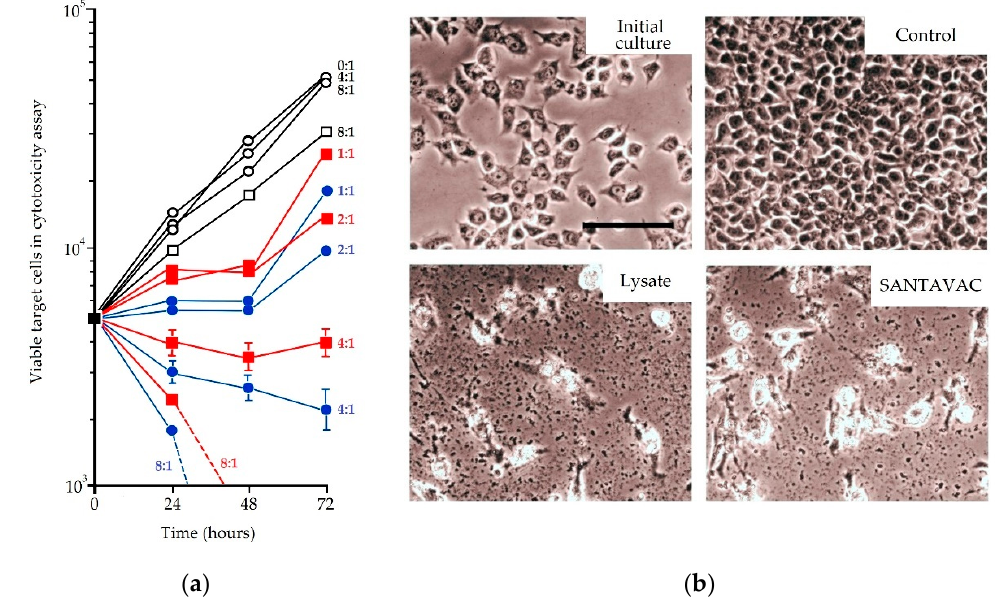
Figure 1. Antigenic equivalence of Set of All Natural Target Antigens for Vaccination Against Cancer (SANTAVAC) to whole cell lysate. ( a ) Cytotoxicity of effector CTLs against MCF-7 cells. Target MCF-7 cells were seeded in tissue culture plates, and then effector CTLs were added at CTL:MCF-7 ratios ranging from 1:1 to 8:1. A ratio of 0:1 indicates growth of MCF-7 cells to which effector CTLs were not added. ( ● ) MCF-7 cells incubated with CTL that had been stimulated with SANTAVAC-loaded DCs. ( ■ ) MCF-7 cells incubated with CTL that had been stimulated with lysate-loaded DCs. ( ) MCF-7 cells incubated with CTL that had been stimulated with unloaded DCs. ( ○ ) MCF-7 cells grown either alone, or with unstimulated PBMC. Points represent the mean value of three identical measurements. As an example, the standard deviation for the 4:1 ratio is shown (similar values for standard deviation were obtained using other CTL:MCF-7 ratios). ( b ) Images for target MCF-7 cells: ‘ Initial culture’ : Initial cell culture of MCF-7 cells. ‘ Control’: Control MCF-7 cells grown alone, ‘ Lysate’: MCF-7 cells incubated with CTLs that had been stimulated with dendritic cells loaded with whole cell lysate, ‘ SANTAVAC’: